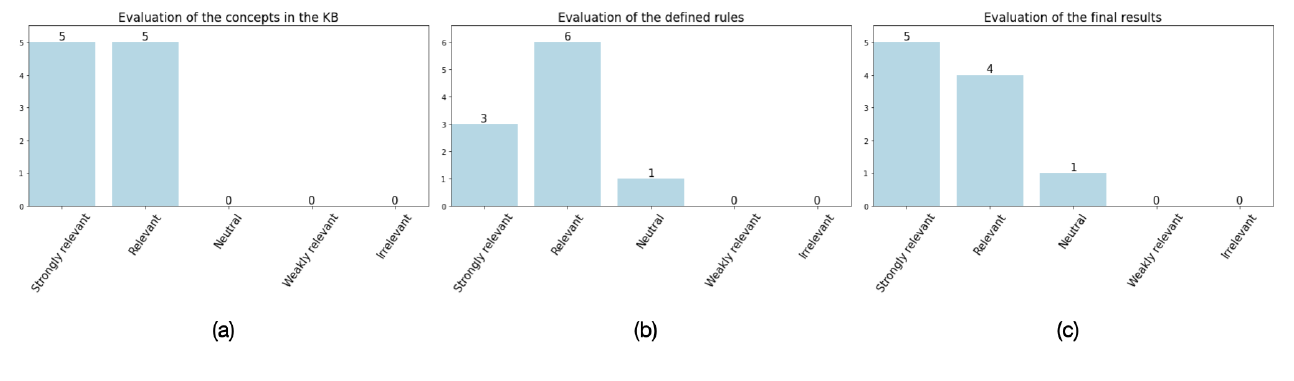
Figure 9. Evaluation of the hypotheses using the data acquired throughout the user study: ( a ) Eval- uation of the concepts in the KB, ( b ) Evaluation of the defined rules, and ( c ) Evaluation of the final